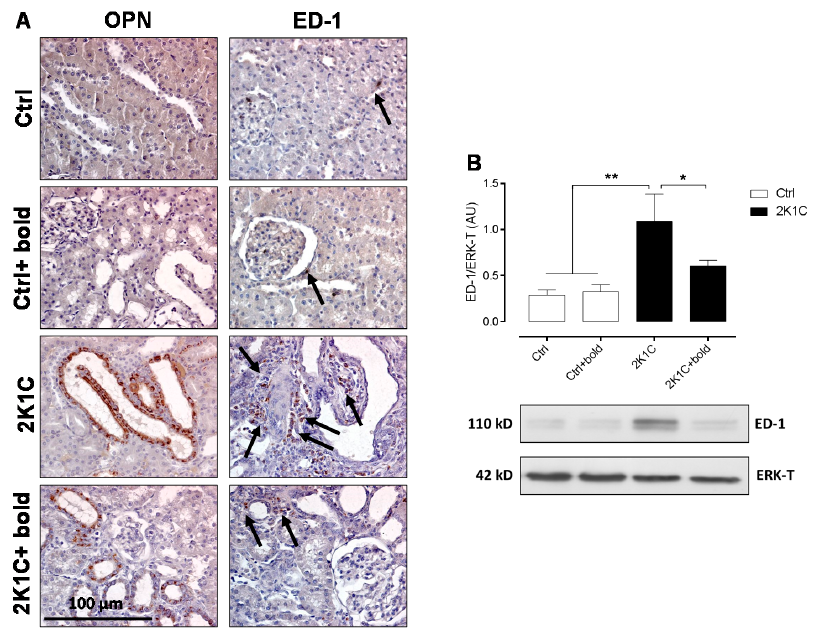
Figure 4. Boldine reduces renal tissue damage in 2K1C hypertensive rats. ( A ) Sirius Red staining, α - SMA, and Col III immunostaining were performed in renal samples six weeks after 2K1C rats were made with hypertension; ( B ) Morphometric analysis of Col III staining in interstitial renal tissue. Representative pictures of at least three different kidneys are shown. Scale bar = 100 μ m. Red staining depicts collagen, while brown staining depicts α -SMA or Col III. The differences were evaluated by analysis of variance followed by the Tukey post-hoc test. ** p < 0.01 vs. 2K1C ( n = 5/all groups).